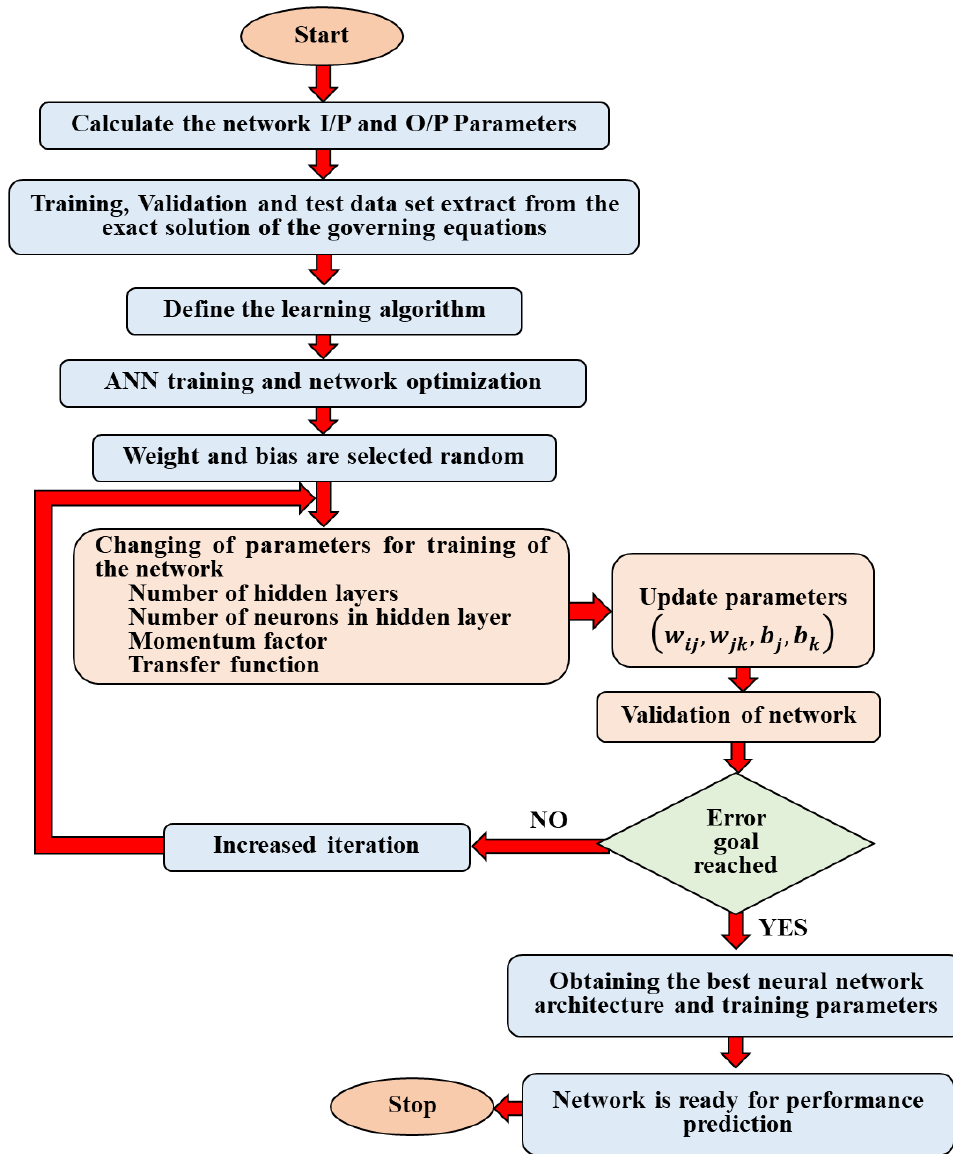
Figure 10. The flowchart of the ANN model framework.